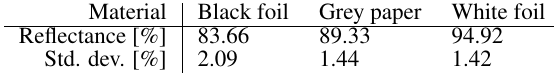
Figure 1. Measurement setup. Left: RIEGL VZ-2000i, center: Table 1. Reflectance values at 0 ◦ incidence angle for the Leica TCRA705power, right: RIEGL VZ-400. In the different surface materials. background, the experiment board can be seen at a range of 30m . The experiment was carried out in a basement which allows a maximum target range of about 250m .